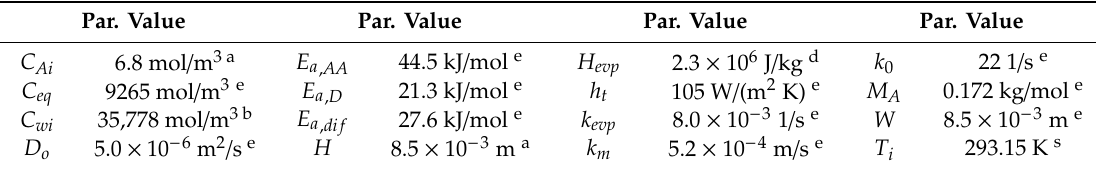
Table 1. Input parameter values.